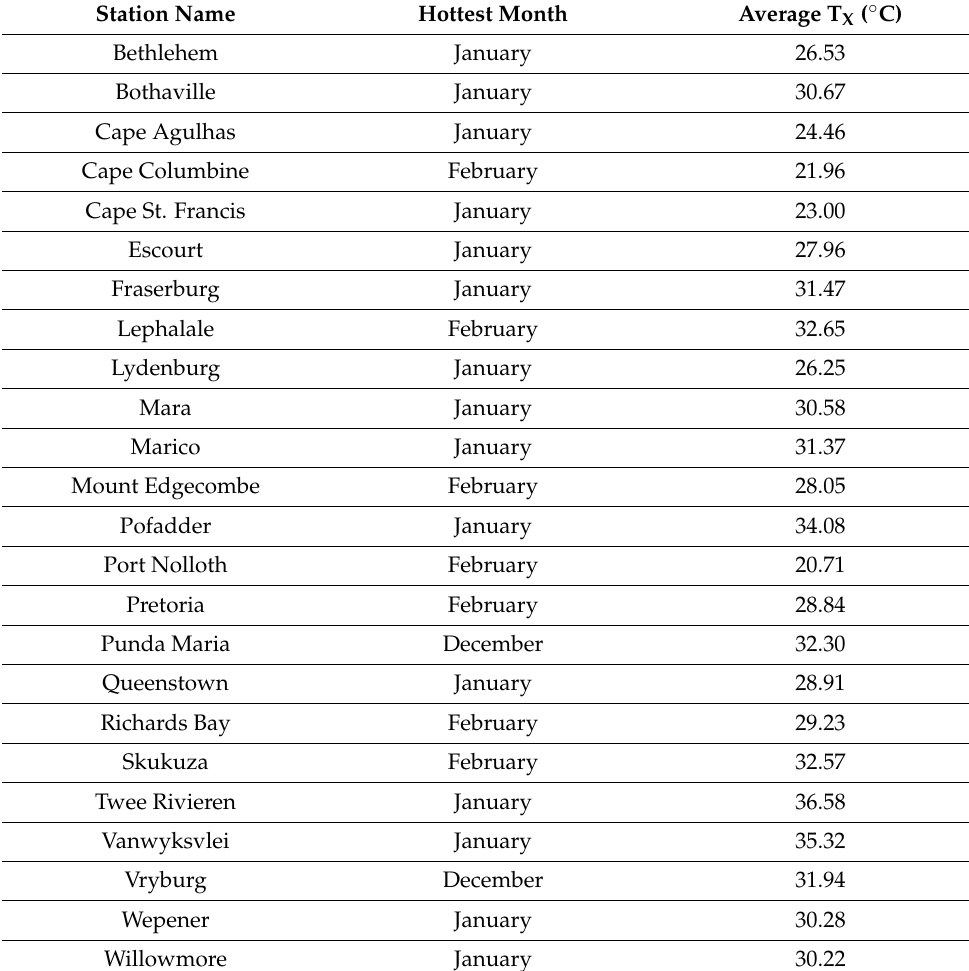
Table 2. Hottest month per station and its average maximum